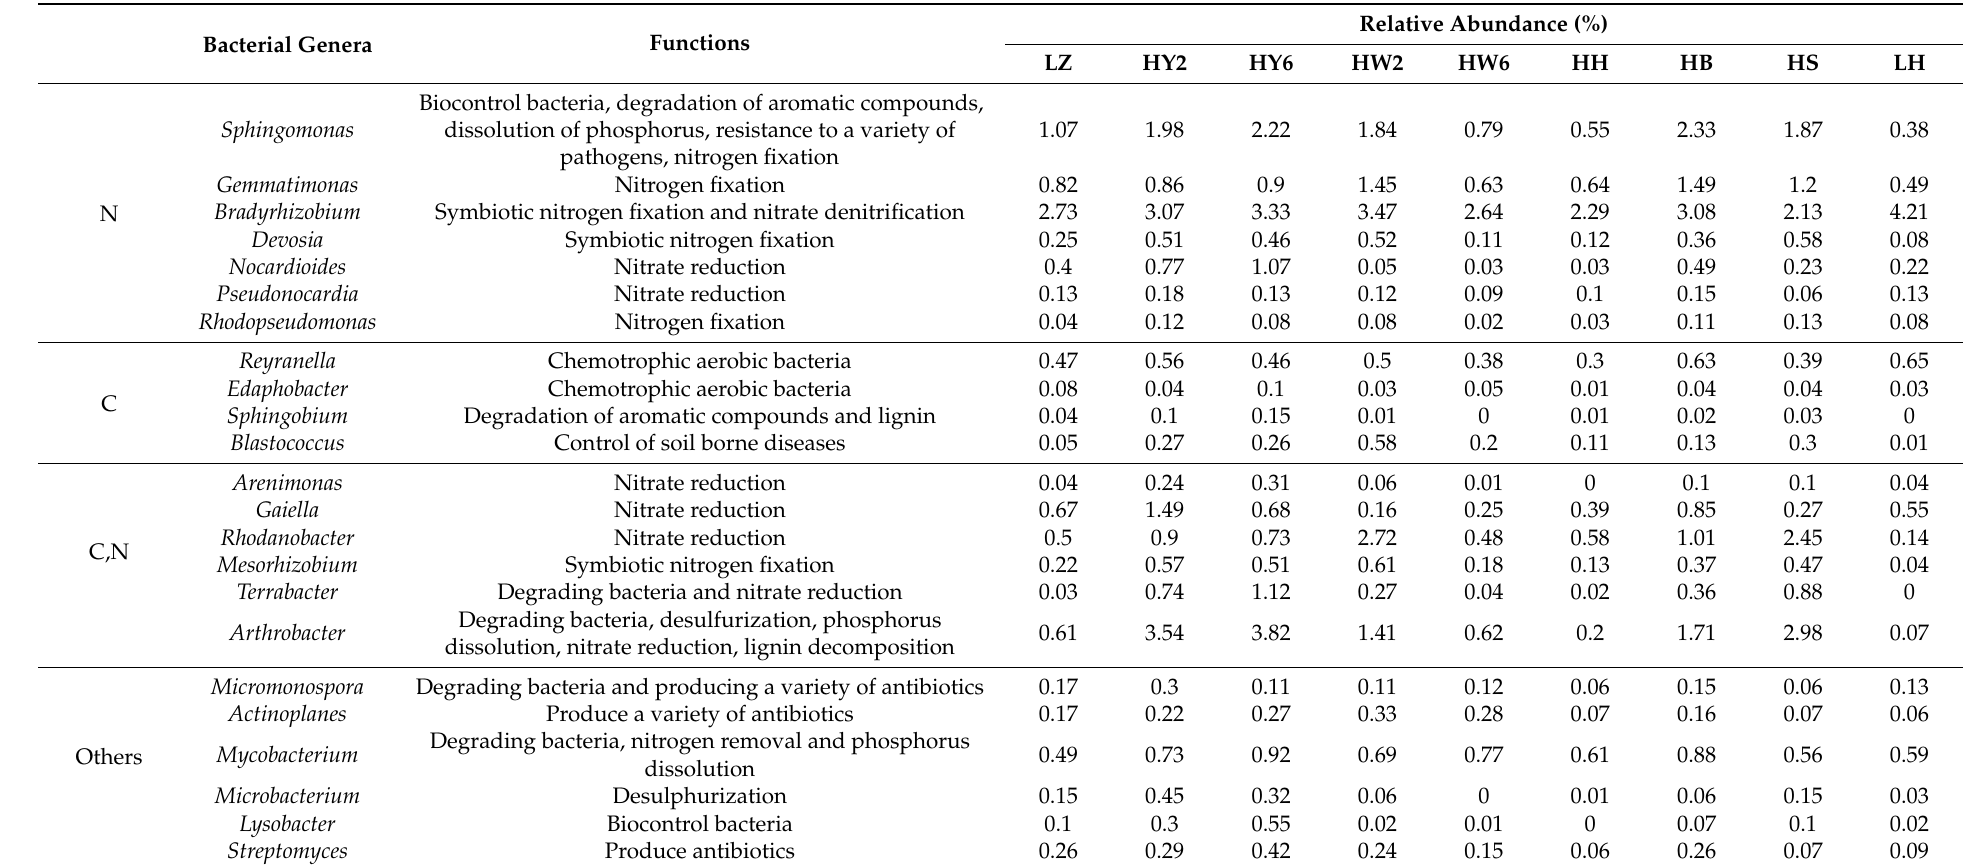
Table 4. Relative abundance of functional bacterial genera in different continuous cropping